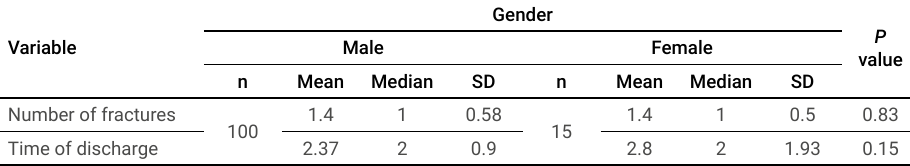
Table 3. Difference of medians of the number of fractures and time of hospital discharge between male and female maxillofacial trauma patients. Variable